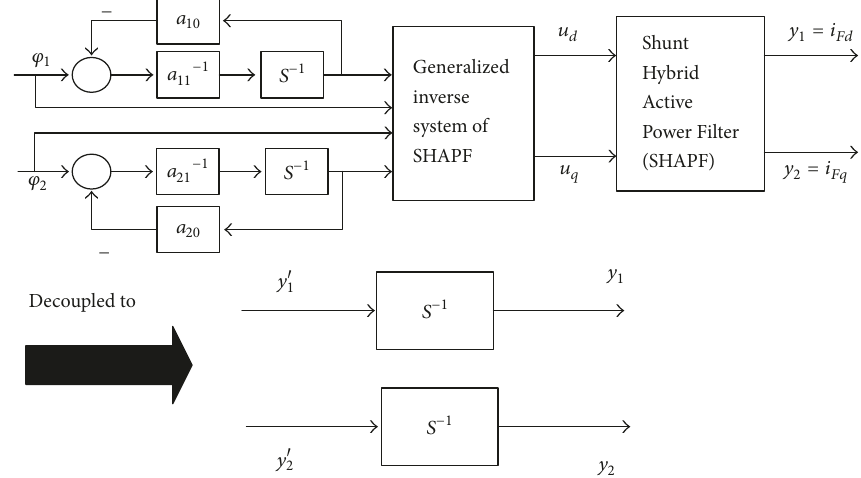
Figure 2: Feedback linearization and decoupling of SHAPF with generalized inverse system